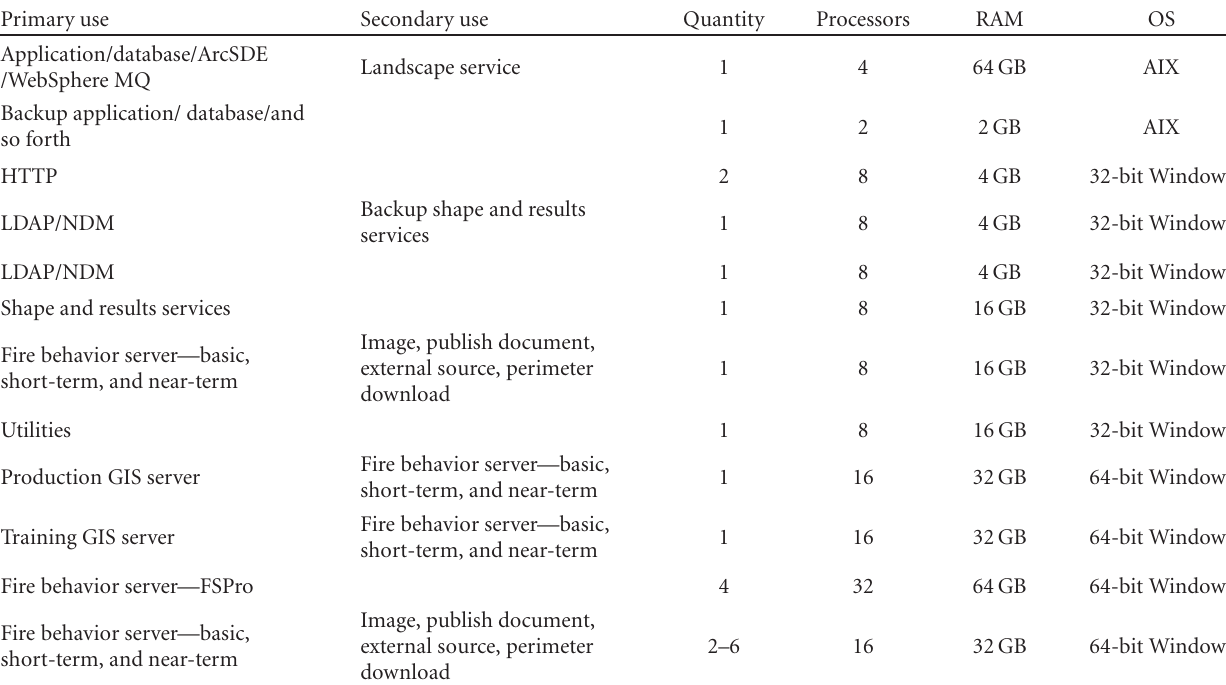
Table 3: Specifications of the physical servers shown in Figure